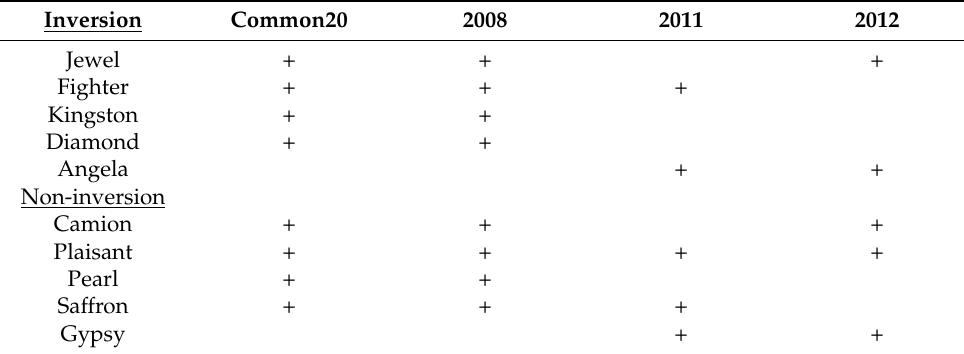
Table 15. Cultivars selected as most likely to represent tillage adaptation traits.